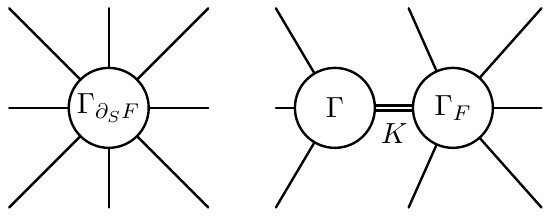
Figure 2 . Diagrammatic representation of (4.5). See text for